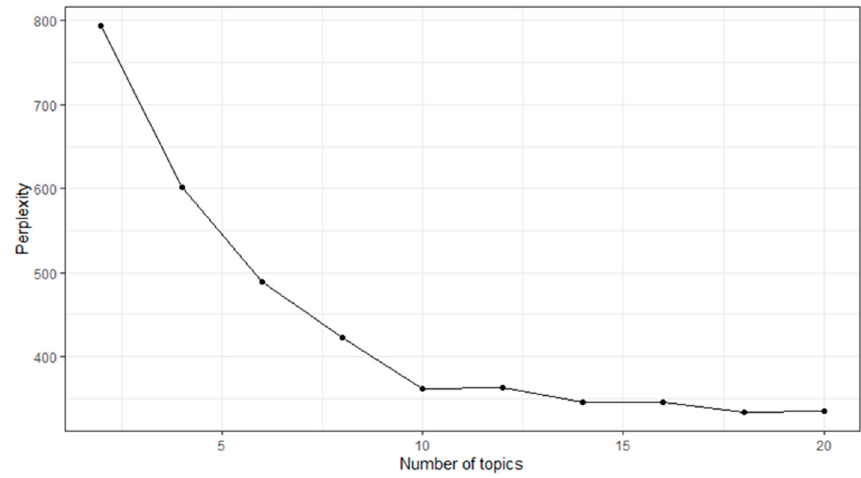
Figure 5. Topic number and perplexity (E11).